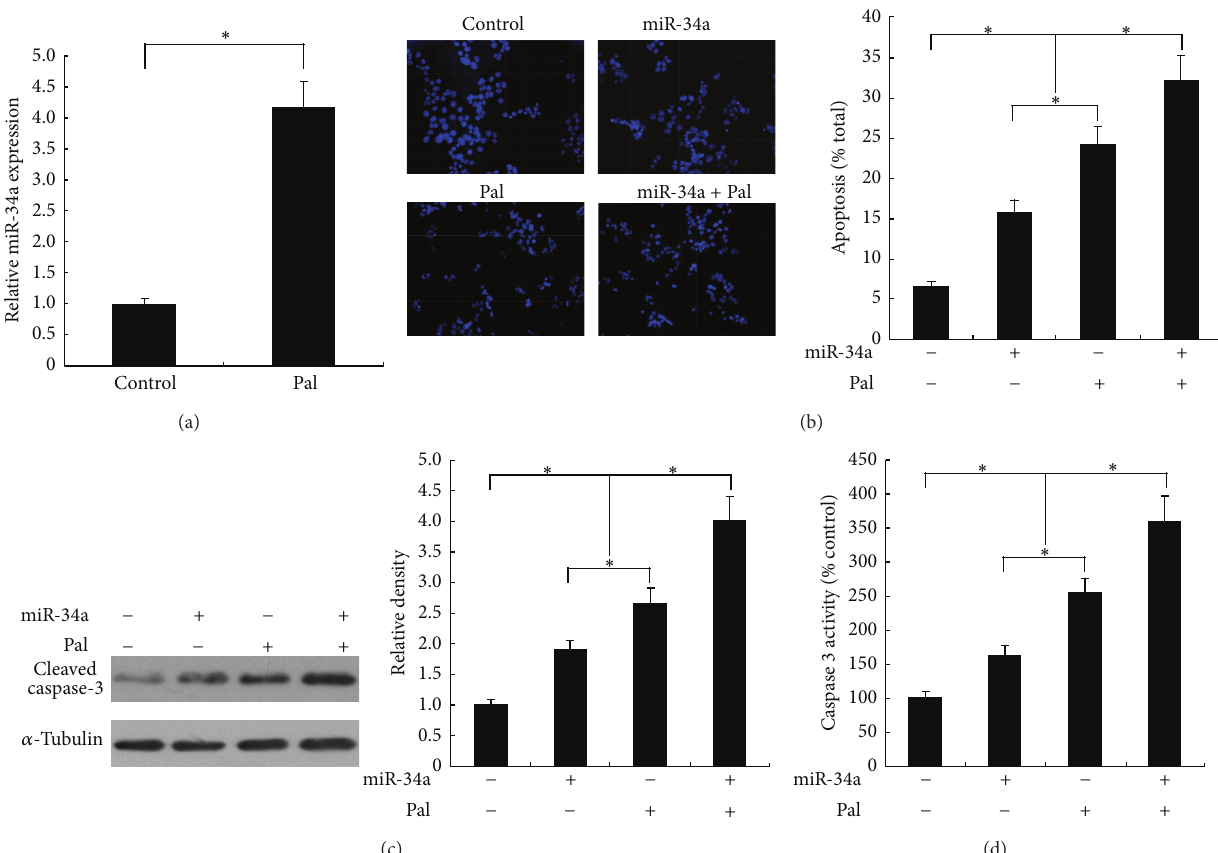
Figure 1: MiR-34a involves in palmitate-induced Min6 cells apoptosis. (a) miR-34a expression level was elevated in response to palmitate treatment. (b) ectopic expression of miR-34a enhanced Min6 cell apoptosis. Cells transduced or not with miR-34a were treated with palmitate (500 𝜇 M) or not for 2 days. The apoptotic rate of cells was determined by scoring the cells displaying pycnotic nucleus and/or fragmented nucleus. Cleaved caspase-3 expression (c) and caspase-3 activity (d) were carried out to confirm the proapoptotic role of miR-34a in Min6 cells. For (a), (b), (c) and (d), data are shown as means ± SD of three independent experiments. ∗ 𝑃 < 0.05 .